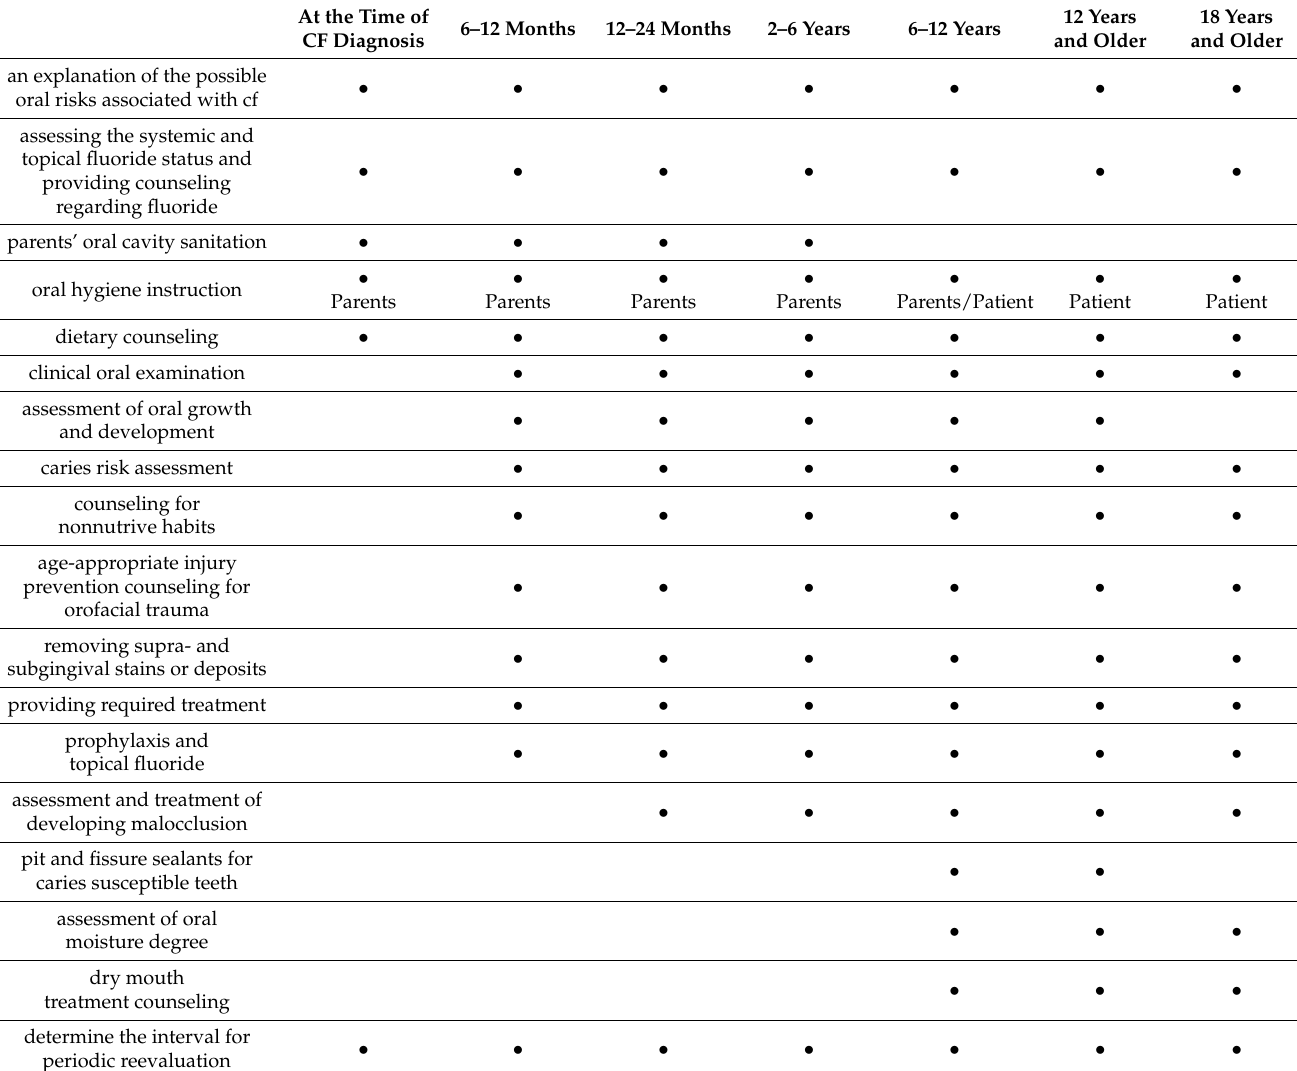
Table 1. Recommended dental schedule for cystic fibrosis (CF) patients (min. every 6 months or as